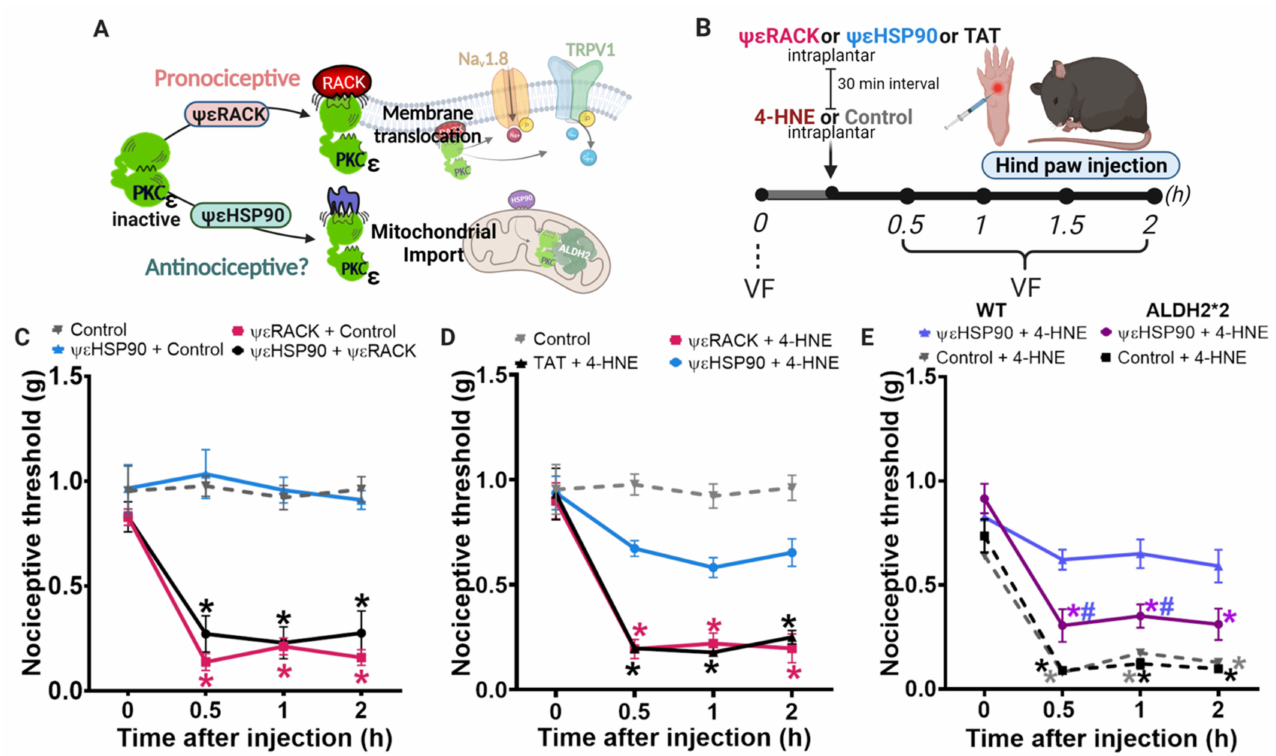
Figure 3. The global activation of PKC ε is pro-nociceptive and the mitochondrial activation of PKC ε blocks 4-HNE-induced nociception. ( A ) Schematic panel showing cytosolic and mitochondrial targets of PKC ε . ( B ) Schematic panel of drug administration and von Frey filament test (VF) in wild type or ALDH2*2 animals (mice with impairment in ALDH2 activity). ( C ) Ψ ε HSP90 (1 µ g/paw), Ψ ε RACK (1 µ g/paw) i.pl. were administered 30 min before the vehicle or Ψ ε HSP90 (black line). ( D ) Ψ ε HSP90 (1 µ g/paw) or TAT (1 µ g/paw) were administered 30 min before the 4-HNE or vehicle (gray line). ( E ) WT and ALDH2*2 received Ψ ε HSP90 or TAT (1 µ g/paw). Two-way analyses of variance (ANOVA) with post-hoc testing by Tukey. * p <0.05 when compared with the baseline (time 0). # p < 0.05 when compared to the vehicle group (control). Error bars represent mean ± SEM; n = 6–8 per condition. Pain assessment was carried out by an observer blinded to the experimental